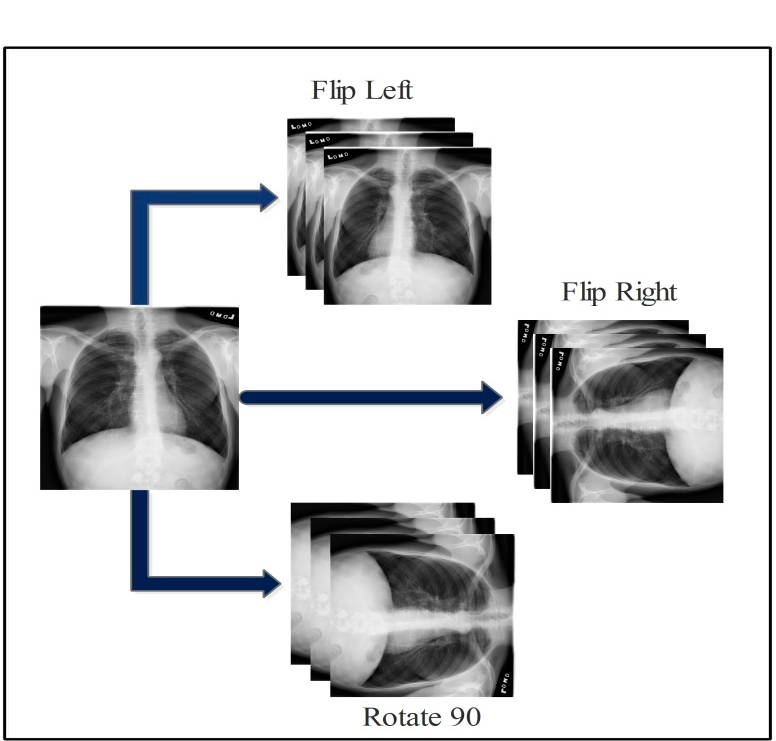
Figure 3. Visual presentation of augmentation process for COVID-19 datasets.